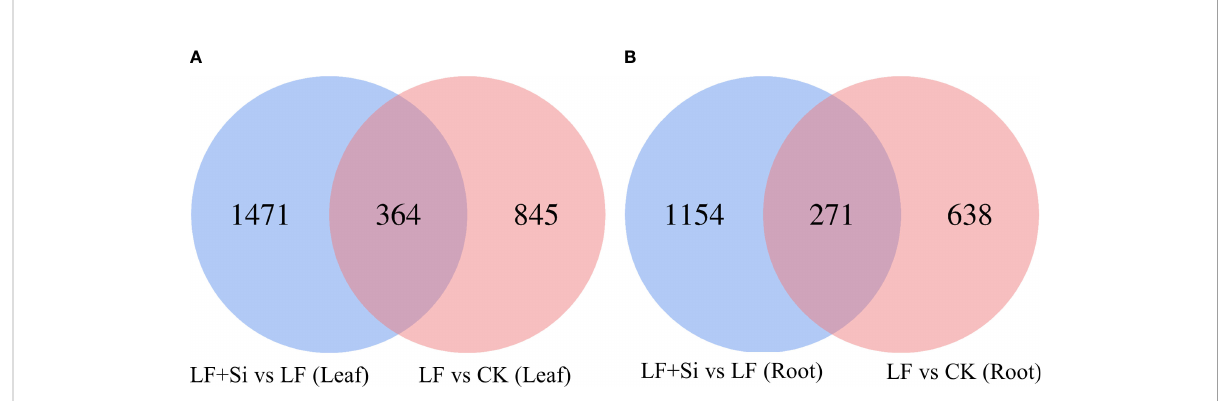
FIGURE 1 Venn diagram of differentially expressed genes in tomato seedlings as in fl uenced by Fe de fi ciency and Si application. (A) The differentially expressed genes in leaves. (B) The differentially expressed genes in roots. Control (CK): 100 m mol/L Fe+ 0 mmol/L Si, Fe de fi ciency treatment (LF): 1 m mol/L Fe + 0 mmol/L Si, and Fe de fi ciency and Si application (LF+Si): 1 m mol/L Fe + 1.5 mmol/L